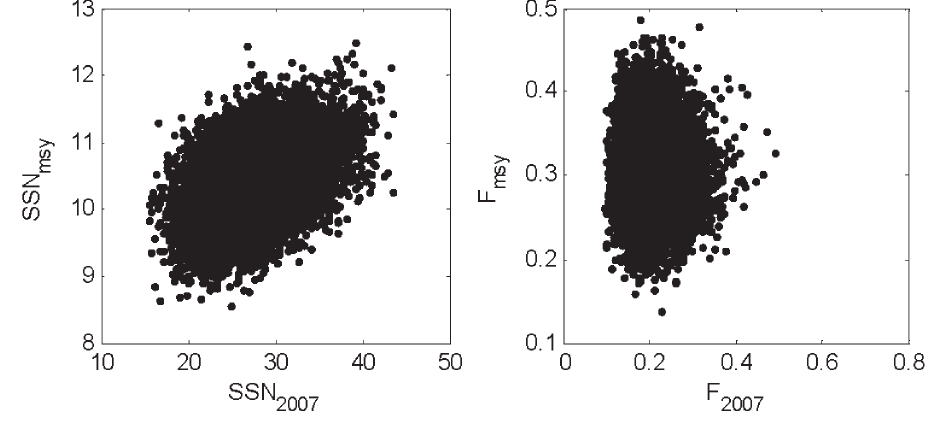
Fig . 9. – Joint posterior distributions of F and F